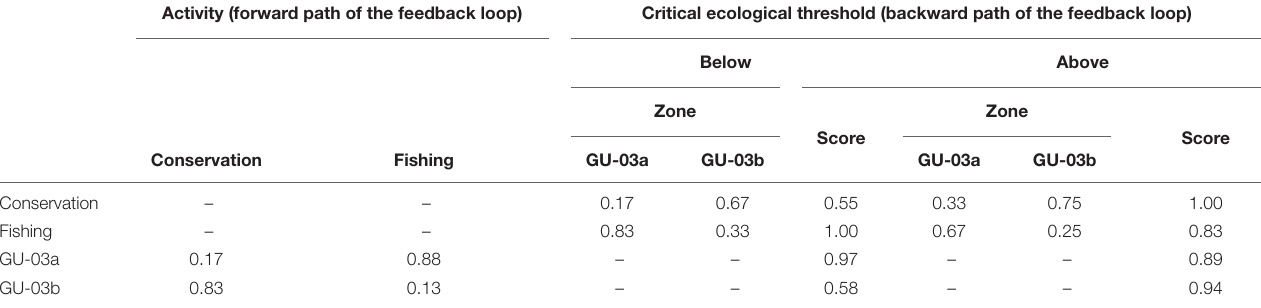
TABLE 4 | Analytical Network Process’s results. Assessment of the relative impact of the banning costs from activity allocation in GU-03. Activity (forward path of the feedback loop) Critical ecological threshold (backward path of the feedback loop) Below